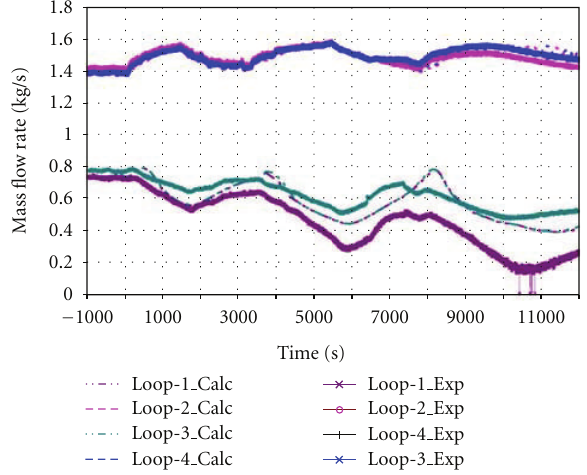
Figure 16: Run-3: Loops flow rate evolutions.